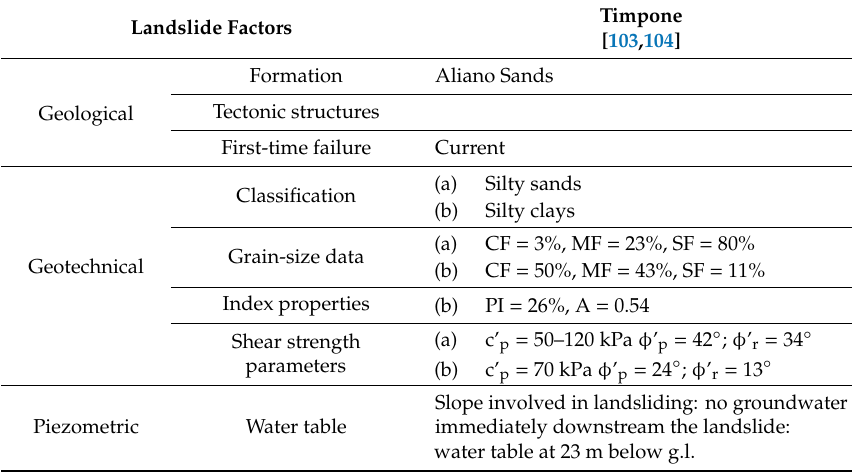
Slope involved in landsliding: no groundwater Water table immediately downstream the landslide: water table at 23 m below g.l.